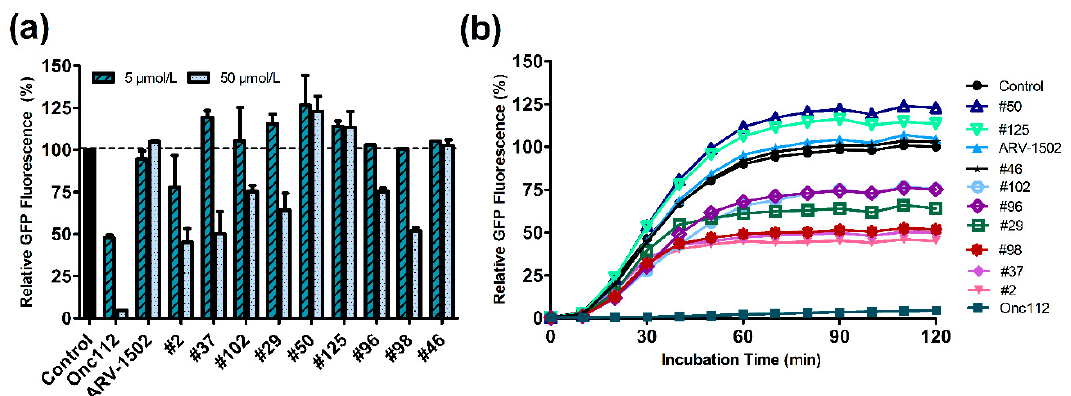
Figure 7. Cell-free GFP expression assay using E. coli 70S ribosome, sfGFP DNA template, release Factor RF1, and one PrAMP to be tested. GFP expression was monitored by the GFP fluorescence using to peptide concentrations of 5 and 50 µmol/L corresponding 2.5- and 25-fold peptide excess, respectively, ( a ) and expression kinetics for the highest peptide concentration (50 µmol/L, ( b )).